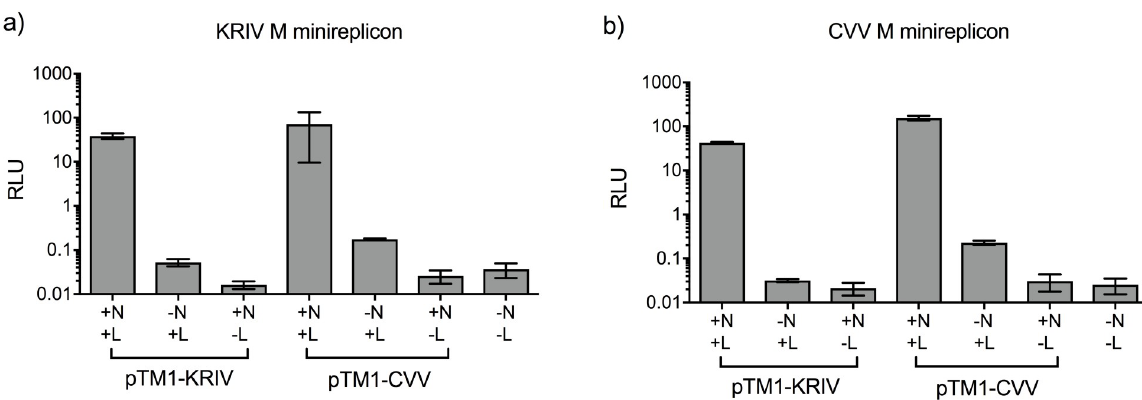
Fig 7. Cross-recognition of UTRs between CVV and KRIV in minigenome activity assay. BSR-T7/5 CL21 cells were transfected with pTM1-N and/or pTM1-L and M-derived minigenome plasmids (as described in Methods) pUC57-T7-KRIVMRen(-) (a) , or pUC57-T7-CVVMRen(-) (b) . Firefly luciferase (FF)-expressing pTM1-FF-Luc was used as a transfection control. At 24 hrs post-transfection, cells were lysed and Ren and Firefly luciferase activities were measured using Dual-Luciferase Reporter Assay kit (Promega). Luciferase values were normalised and minigenome activity is expressed as relative light units (RLU). Error bars indicate SD (n = 3). This is one representative experiment of three repeats with very similar results. pTM1-CVV or pTM1-KRIV refers to the viral origin of L or N